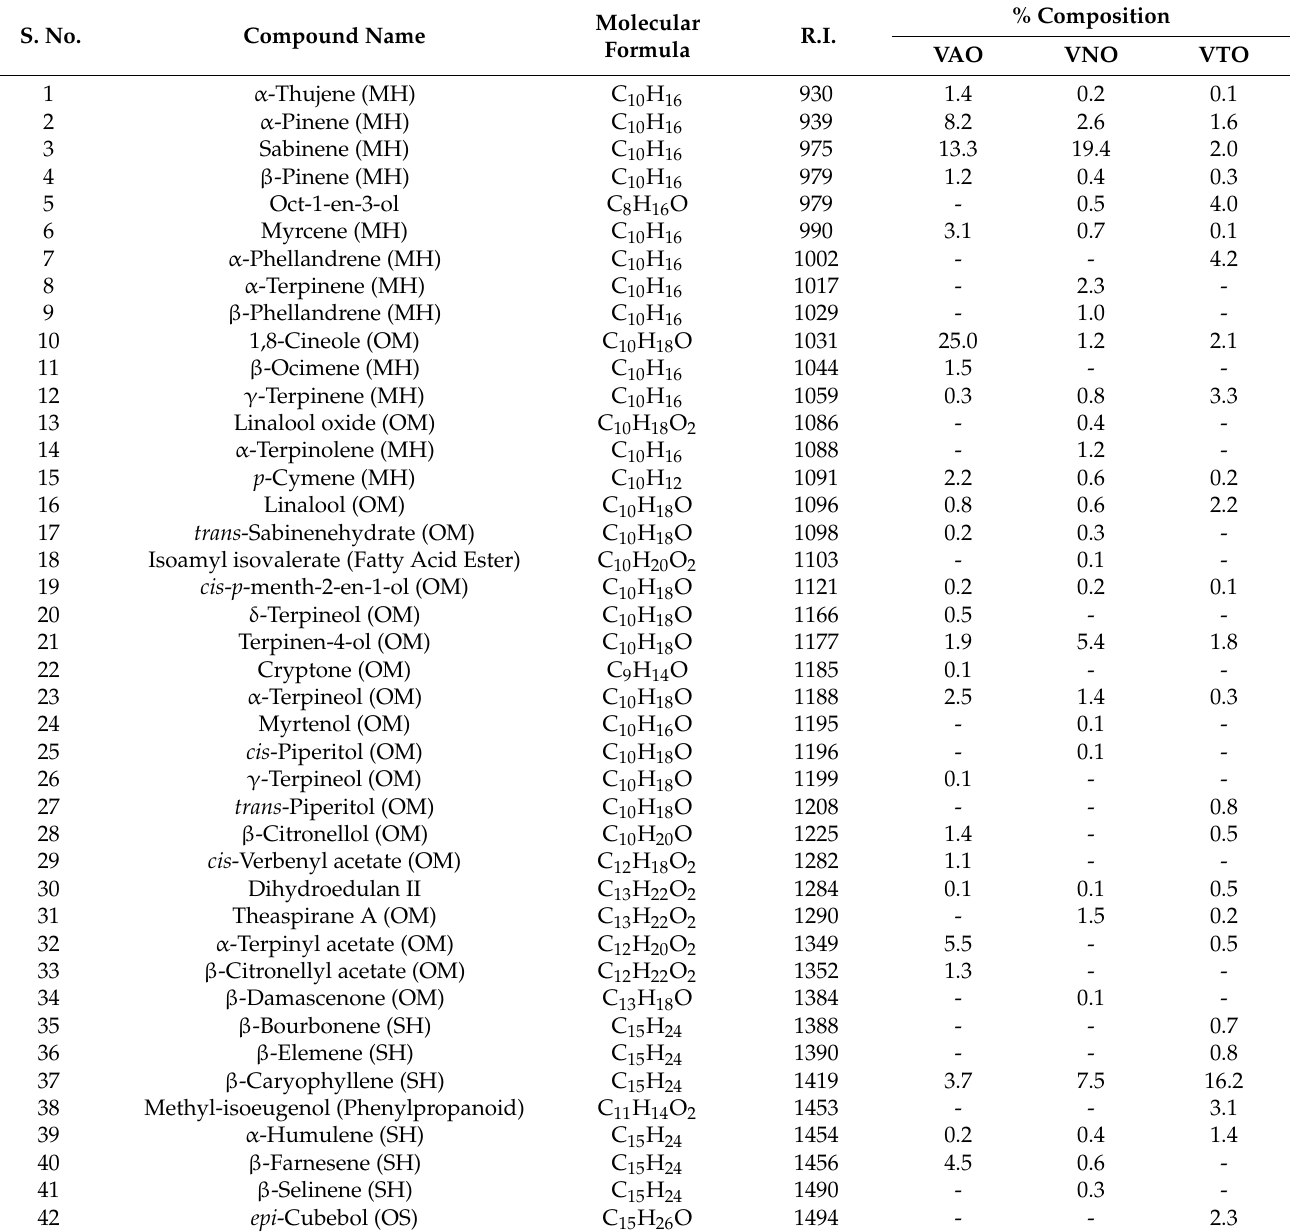
Table 1. Comparative chemical composition of essential oil of Vitex